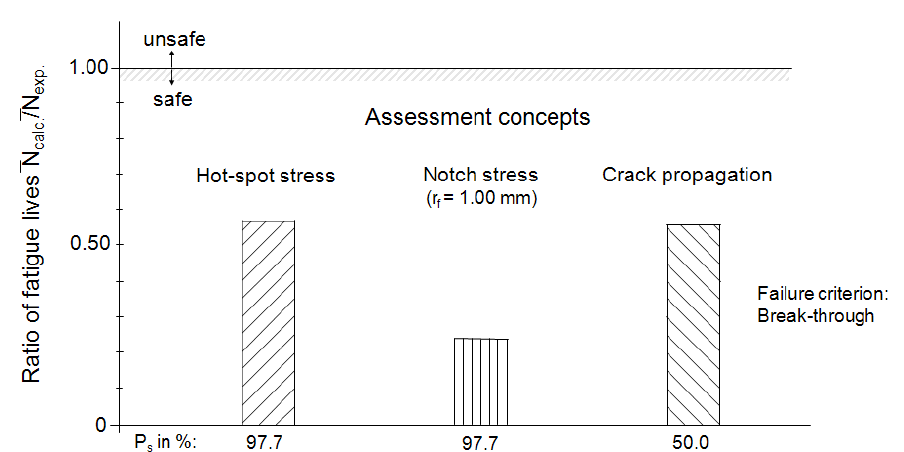
Figure 17: Accuracy of fatigue life estimations according to different concepts by the example of welded K-nodes.